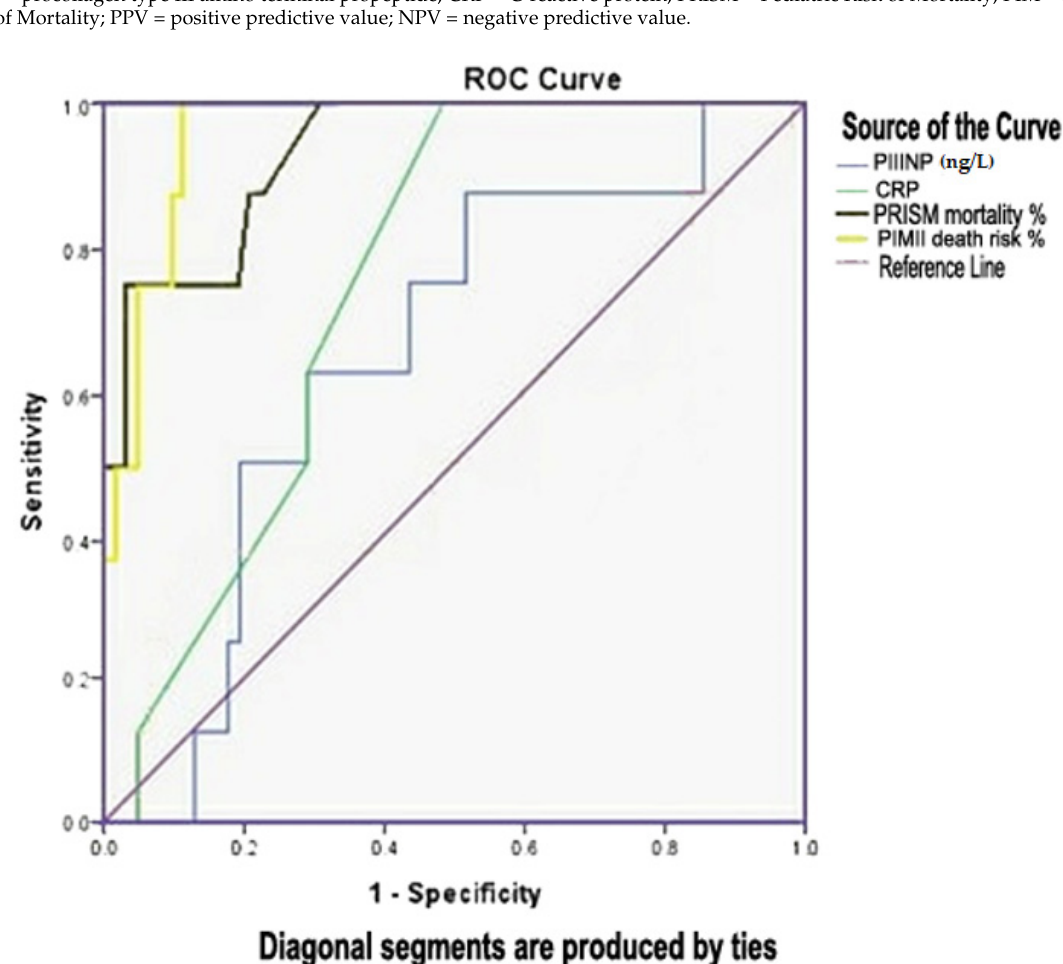
Figure 2. Receiver-operating characteristic (ROC) curve for prediction of